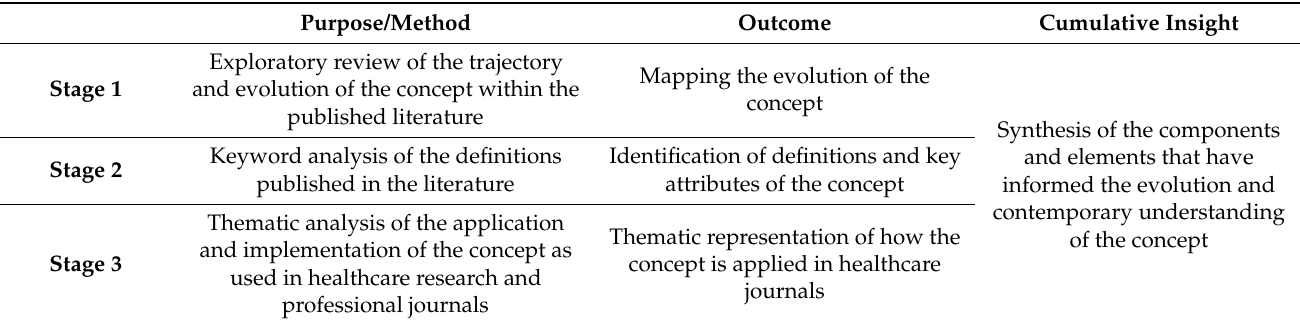
Table 1. Stages in the analytical